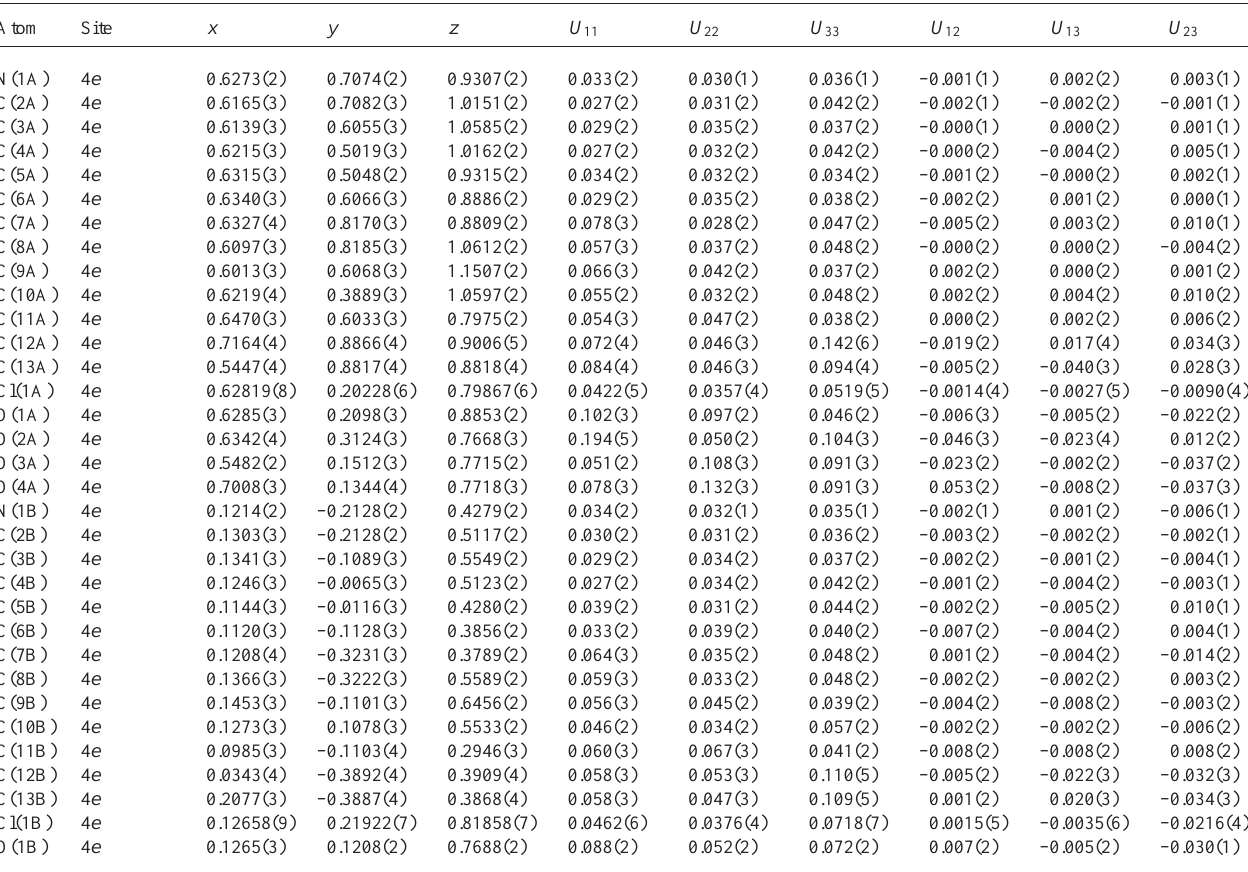
Table 3. Atomic coordinates and displacement parameters (in Å 2 ) .